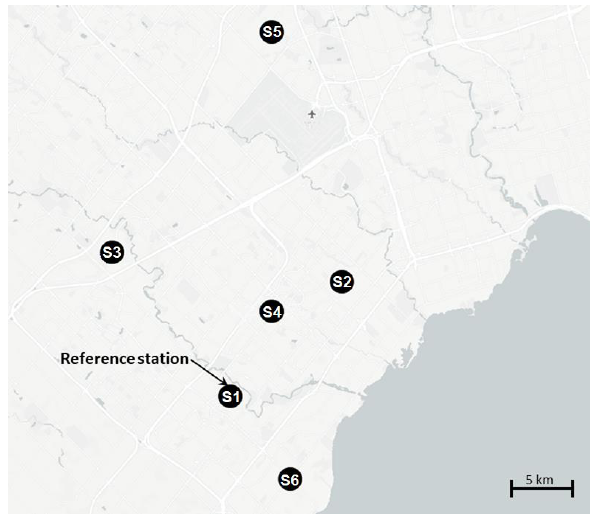
Figure 4. Locations of AirSENCE™ devices O1–O4 in Oshawa,